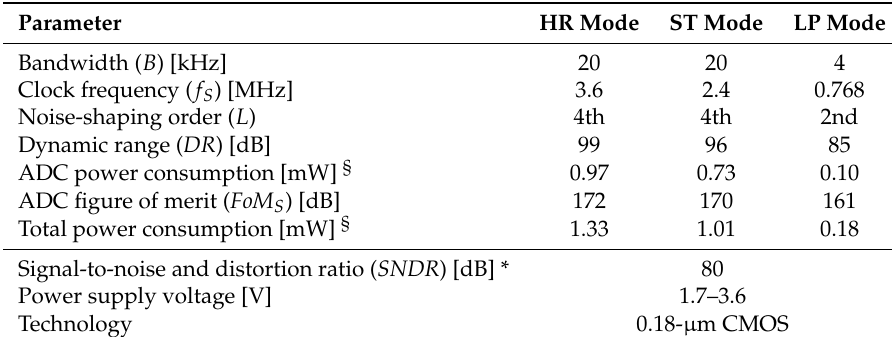
Table 4. Measured performance summary (example 3).